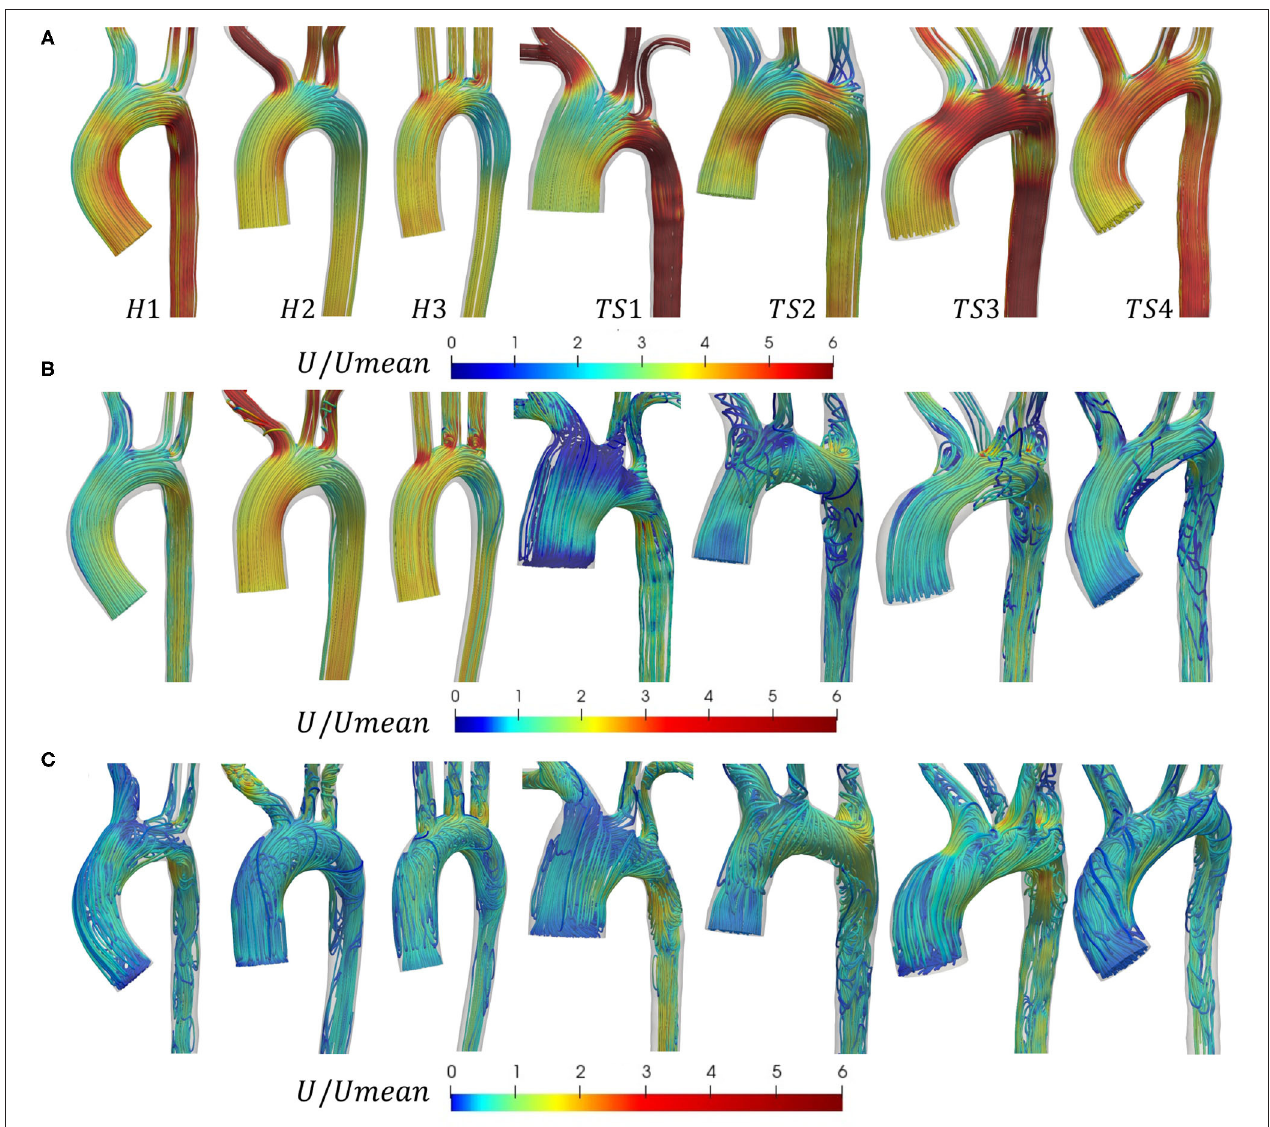
FIGURE 4 | Velocity streamlines in the aortic arch of the healthy (H1-H3) and Turner syndrome (TS1-TS4) girls at (A) peak velocity ( t 1 ), (B) maximum deceleration ( t 2 ), and (C) mid-diastole ( t 3 ), colored by non-dimensional velocity magnitude that is normalized according to the average inlet velocity ( U mean ), derived from patient PC-MRI data (anterior view). Note that the color legends in (B) and (C) were shifted compared to (A) to enhance visualization. For interpretation of the colored legends, please refer to the online version of the